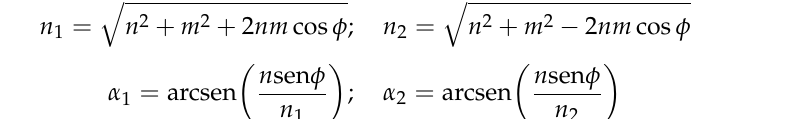
Figure 1. Basic journal bearing geometry: ( a ) elliptical bearing; ( b ) three-lobed bearing. Two circular arcs from the elliptical bearings, being their centers located on the same line and displaced from the center of the bearing by a distance known as “ellipticity” ε . Defining m = ε / C r as the “ellipticity ratio”, the “eccentricity ratios” for the bottom (1) and top (2) lobes are given by Equation (4). With that, it is also possible to write the “equilibrium angles” for each lobe, as follows in Equation (5).